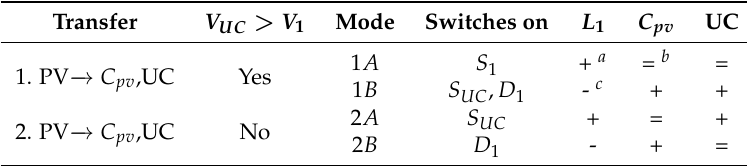
Table 2. Operating modes of the converter associated with the PV. Transfer V UC > V 1 Mode Switches